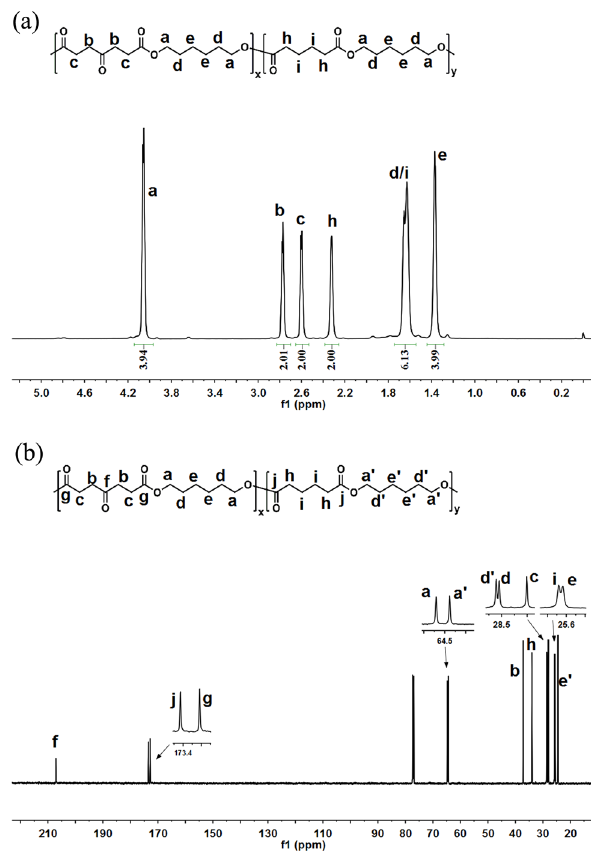
Figure 3: ( a ) 1 H NMR and ( b ) 13 C NMR spectra of the P - 50 copolymer in CDCl 3